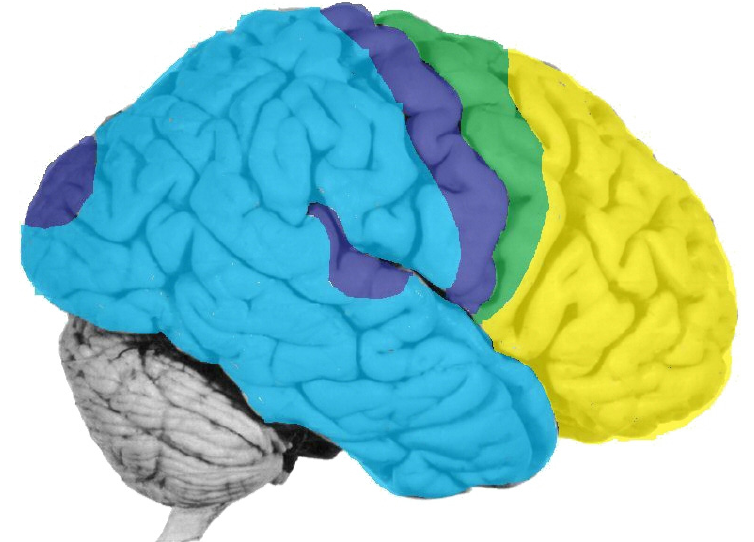
Figure 4. Dark blue = exteroceptive projection cortex; light blue = perceptual association cortex; green = motor projection cortex; yellow = motor association (executive)